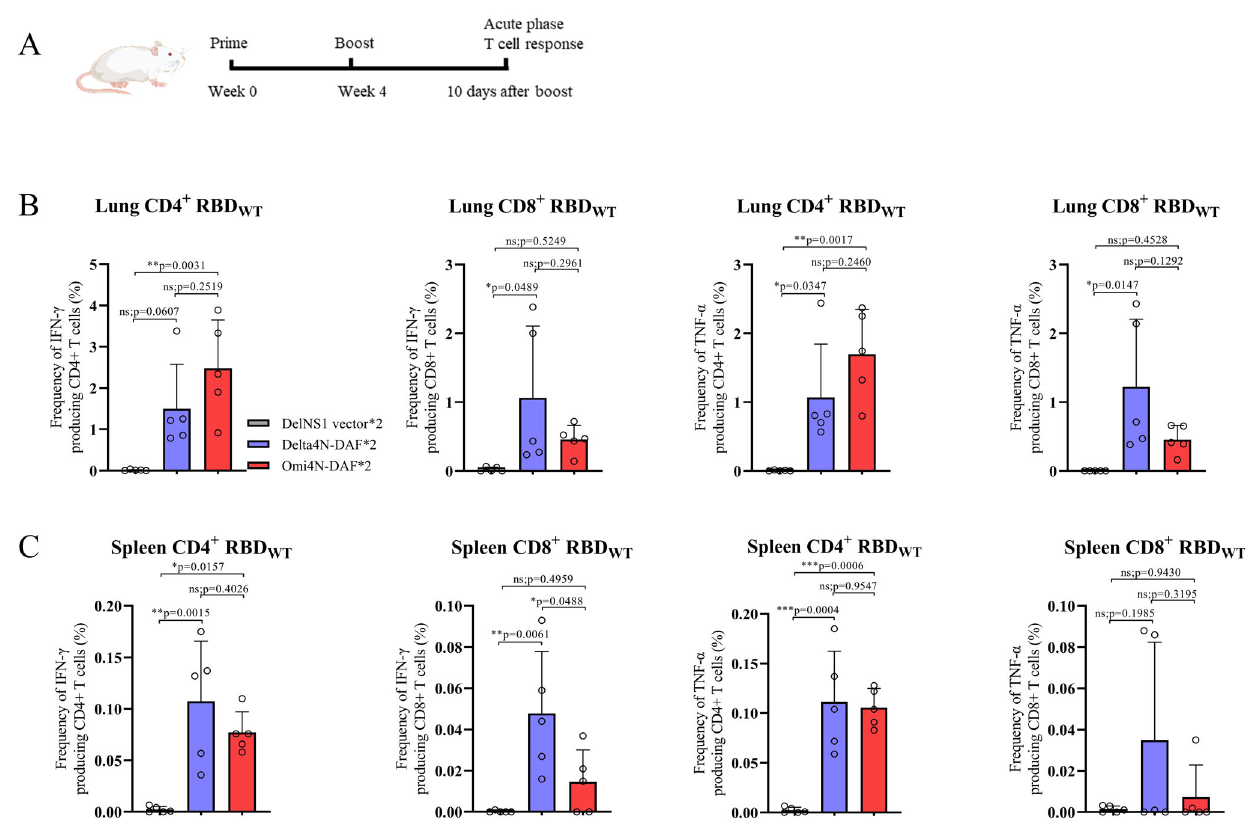
Fig. 3 | DelNS1-RBD4N-DAF LAIV induces CD4+ and CD8+ T cell response. A Schedule for immunization of BALB/c mice. At day 10 after the second immu- nization, lung cells and splenocytes were obtained and stimulated with or without spike peptide pools (Supplementary Table 2) overnight in the presence of BFA. Surface markers (CD4, CD8, and Zombie) were stained, and cells were fi xed and permeabilized. Intracellular cytokines (TNF α and IFN γ ) were then stained with speci fi cantibodies.Delta4N-DAFandOmi4N-DAFinducedIFN- γ andTNF- α positive